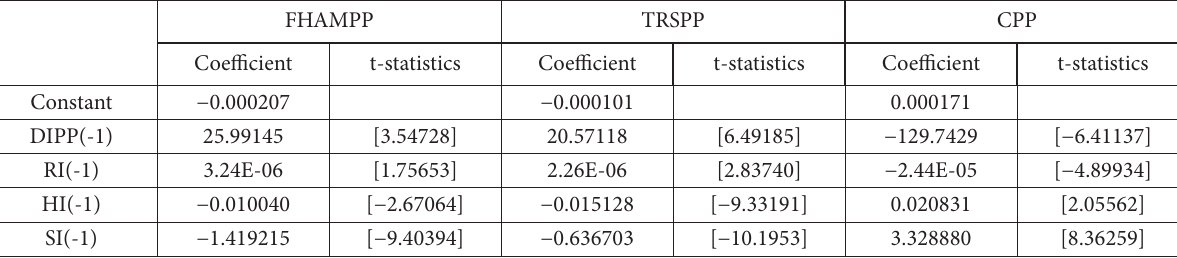
Table 9. Vector error correction model for sub-categories of durable goods consumption (long-term equilibrium relationship)